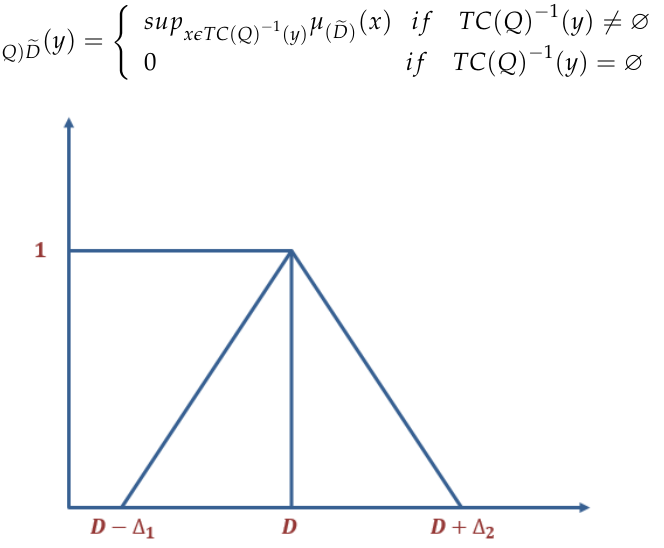
Figure 4. Triangular fuzzy number D .